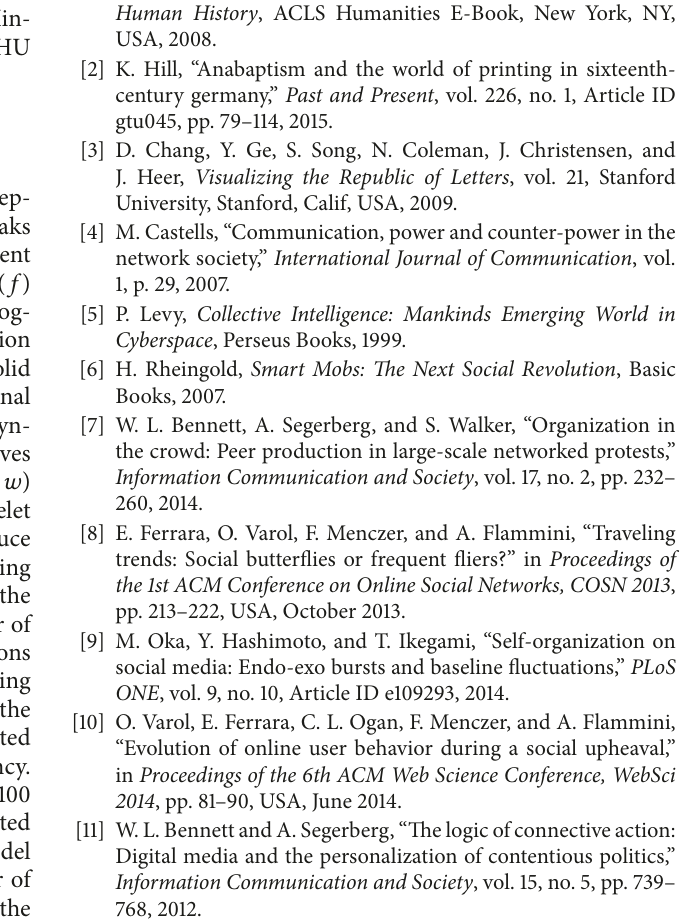
inferred values of 𝐽 𝑖𝑗 for each frequency. (B) Count of the number of metastable states for each frequency. Figure S5: divergence of the heat capacity of the system. (A) Normalized heat capacity 𝐶(𝑇)/𝑁 of the Ising models for sizes 6, 9, and 12 (averaged over 100 random models) and 15, where the larger peaks correspond to larger sizes. (B) Linear trend (solid line) of the peaks of 𝐶(𝑇)/𝑁 (dots) with respect to the size of the system. Table S3: distributions of multi- information ratios. Mean and standard deviation for each distribution in Figure S3. Figure S6: parameters of the Ising models. For each frequency, we depict the parameters ℎ (A) and 𝐽 (B) of the inferred Ising models. Figure S7: transfer (𝜏) for entropy. We represent functions J 𝑘𝑙 (𝜏) = T 𝐸 ∗ →𝐸 ∗ 𝑓𝑘 𝑓𝑙 values of 𝜏 in a range within [1, 2 9 ] (i.e., from 1 minute to 8.5 hours) logarithmically distributed with intervals of 2 0.25 . Rows specify the value of 𝑓 𝑘 while columns specify the value of 𝑓 𝑙 . For each graph, the vertical axis represents the value of transfer entropy and the horizontal axis the value of 𝜏 in minutes. Table S4: metastable states. Metastable state 𝑠 (where positive spins are marked with 1 s and negative with 0 s), probability of the metastable state 𝑃(𝑠) , and basin of attraction of the metastable state 𝐵(𝑠) . (Supplementary